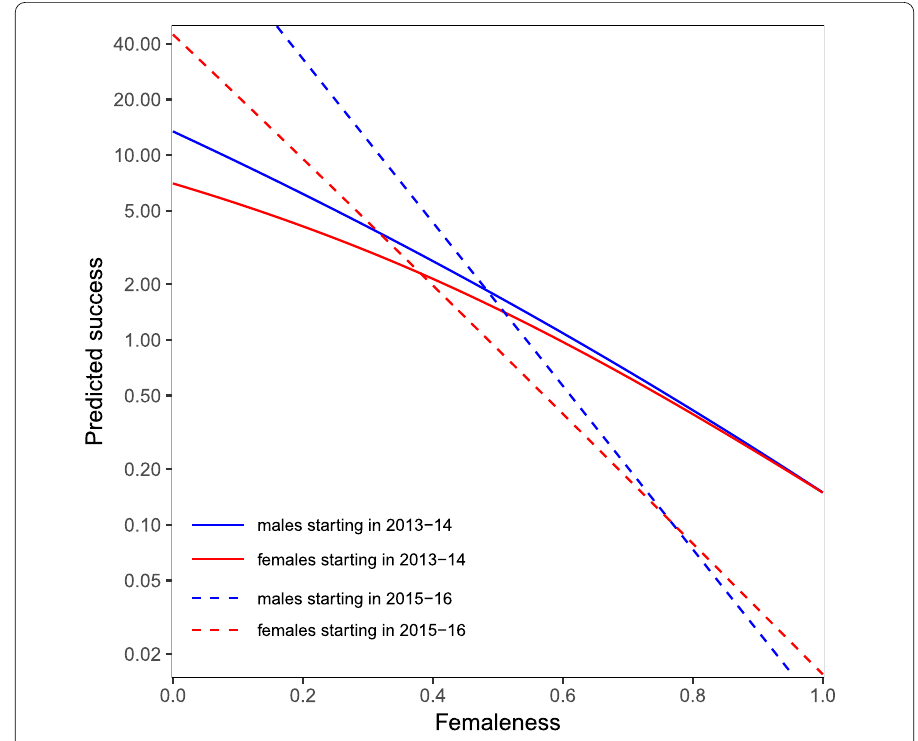
Figure 10 Marginal predictions from zero-inflated negative binomial model (model 1) of success, for femaleness by gender category, separately for those who started in 2013–14, and those who started in 2015–16. As a simple analysis of a time trend, we introduced a variable capturing those who started in the years of 2015 and 2016 (as opposed to starting in 2013 or 2014), and entered interactions for this time variable with categorical and behavioral gender into our model of success (SI9) . We do not see evidence for a mitigating trend in the effect of behavioral gender, in fact, it seems that inequalities in success along the behavioral gender dimension have become more